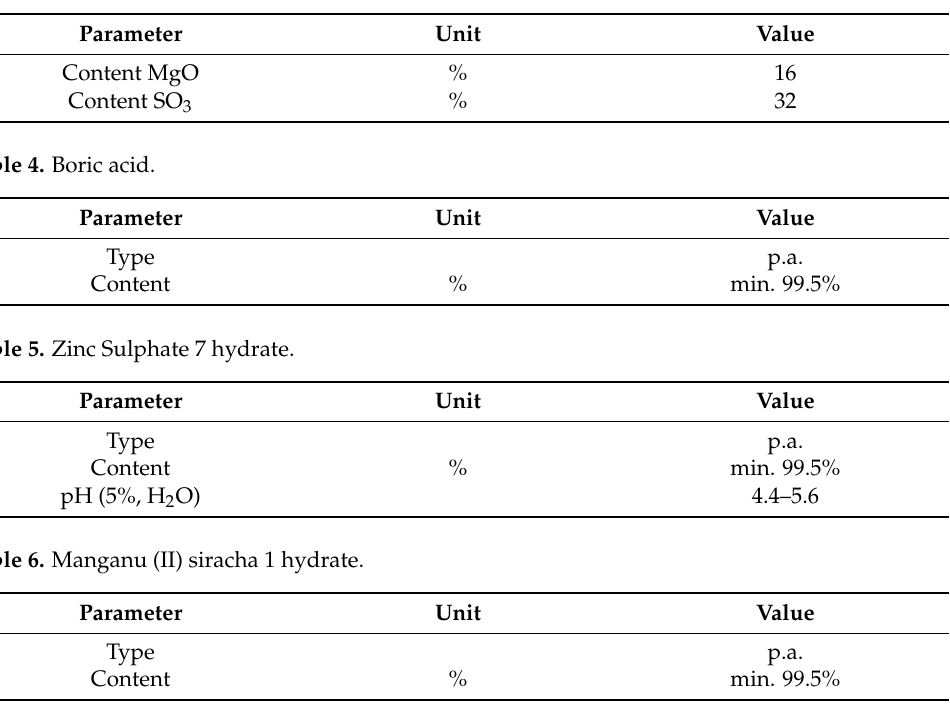
Table 3. Magnesium sulfate 7 hydrate.